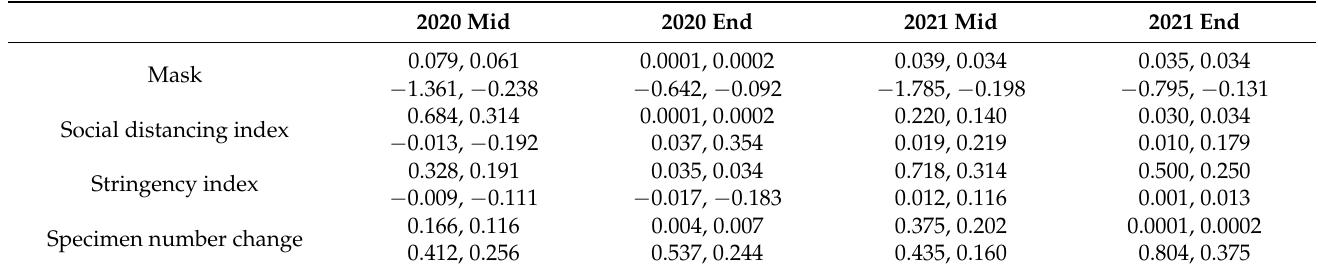
Table 2. Multiple regression analyses for the associations between each measure and influenza detection. (upper left: uncorrected p value, upper right: corrected p value, lower left: unstandardized beta, lower right: standardized